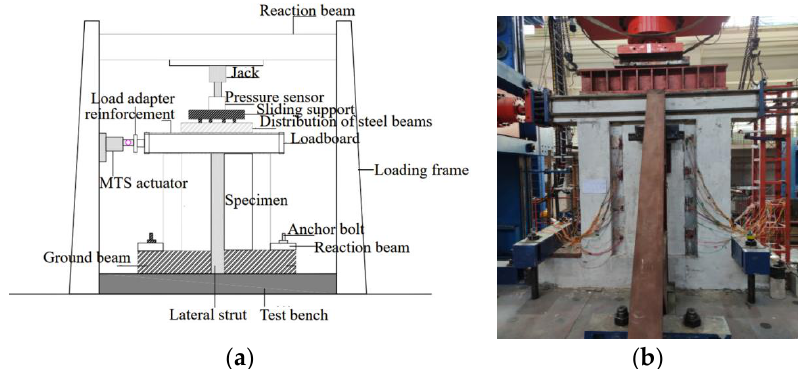
Figure 4. Test loading device. ( a ) Loading device; ( b ) Live loading